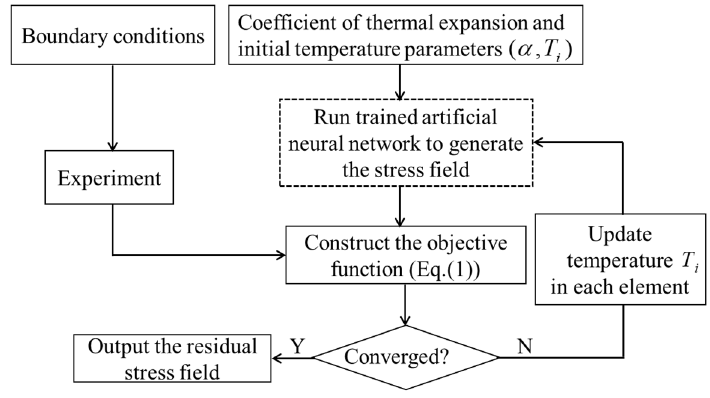
Figure 1. Flow chart of the inverse method.